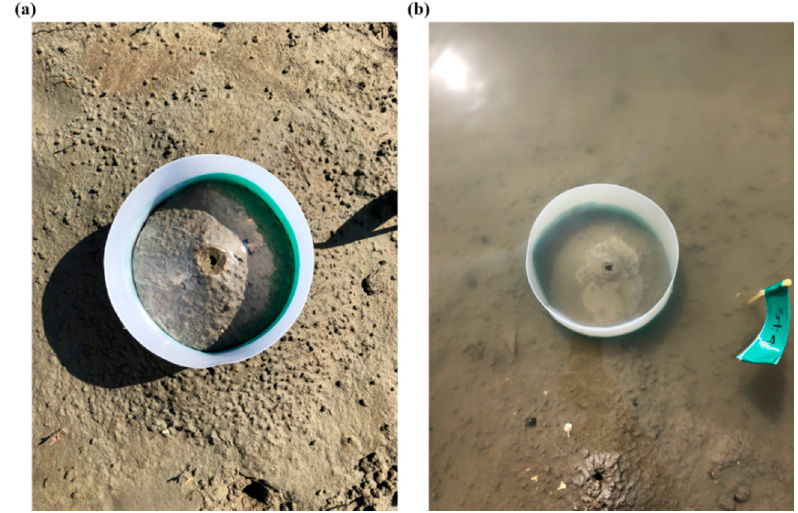
Figure 2. Sediment trap for quantifying expelled sediments ( a ) before and ( b ) after